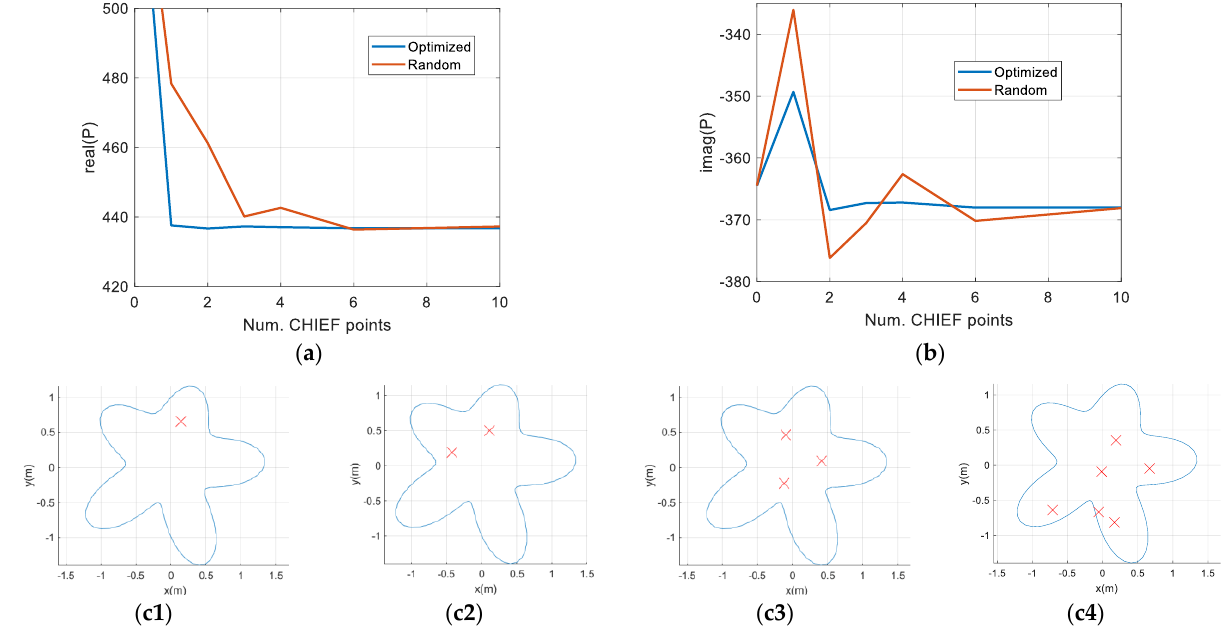
Figure 16. Real ( a ) and imaginary ( b ) parts of the response calculated for different numbers of CHIED points using ALG1 and random point generation and positions of the CHIEF points ( c1 – c4 ) for one, two, three and six points after optimizations are